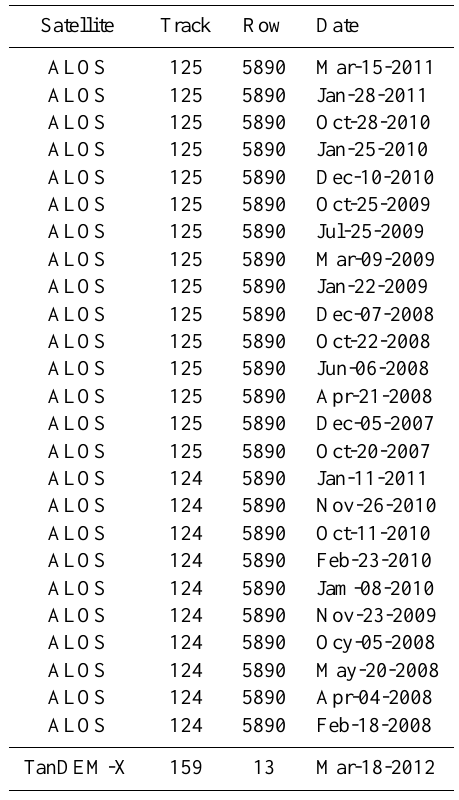
Table 1. SAR imagery used in this study. Satellite Track